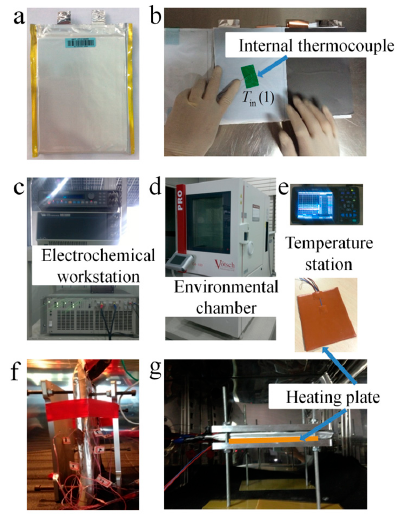
Figure 2. Battery and experimental device. ( a ) The cell sample; ( b ) the location of the internal thermalcouple; ( c ) the electrochemical workstation; ( d ) the environmental chamber; ( e ) the temperature monitor station; and ( f , g ) the locations of the cells during tests.